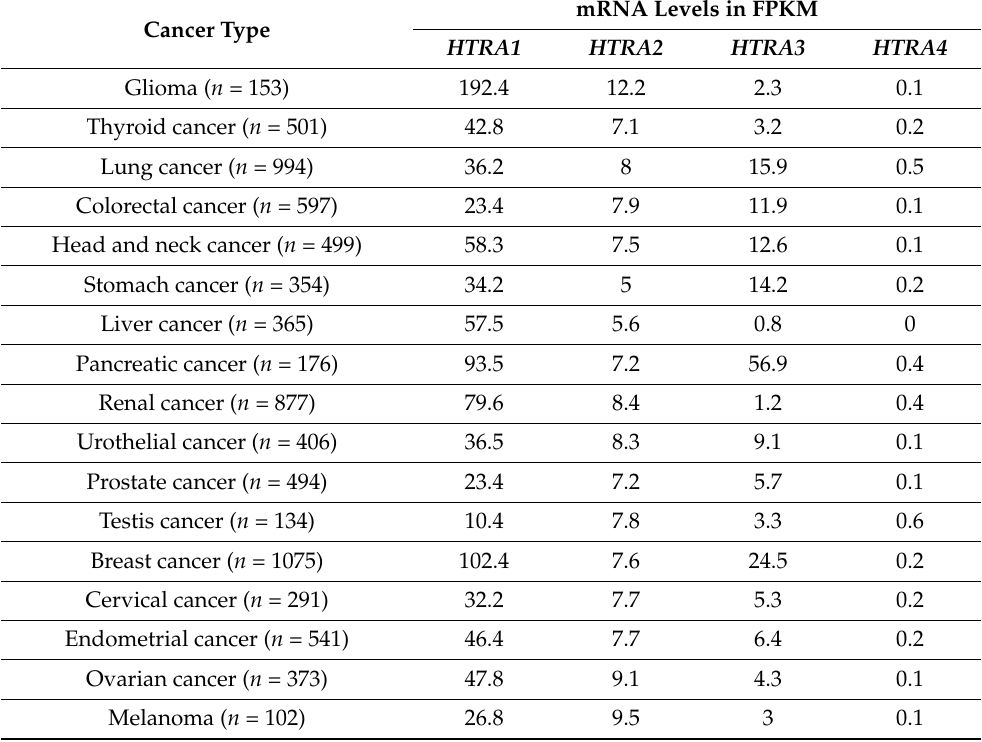
Table 4. Expression of human HtrAs in cancer patients. RNA-seq data extracted from the Cancer Genome Atlas (TCGA) dataset, levels in fragments per kilobase of transcript per million mapped reads